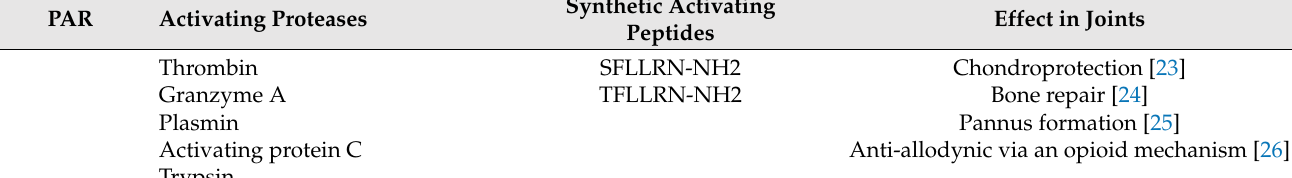
Table 1. Known cleaving proteases and synthetic activating peptides for each of the PARs and their role in arthritis. Synthetic Activating PAR Activating Proteases Effect in Joints Peptides Thrombin SFLLRN-NH2 Chondroprotection [23] Granzyme A TFLLRN-NH2 Bone repair [24] Pannus formation [25] Anti-allodynic via an opioid mechanism